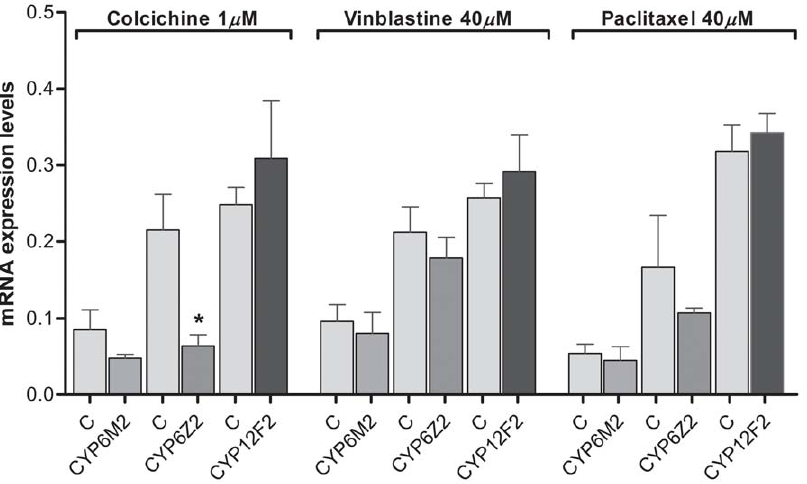
Figure 5. Effect of tubulin inhibitors in P450 cytochromes mRNA expression levels in midguts. Midguts were collected 24 hours after a P. berghei infected blood meal. Colcichine 1 m M, vinblastine 40 m M and paclitaxel 40 m M. Data are shown as mean 6 SEM. *indicates significant differences ( p , 0.05) by Mann-Whitney test one-tailed.